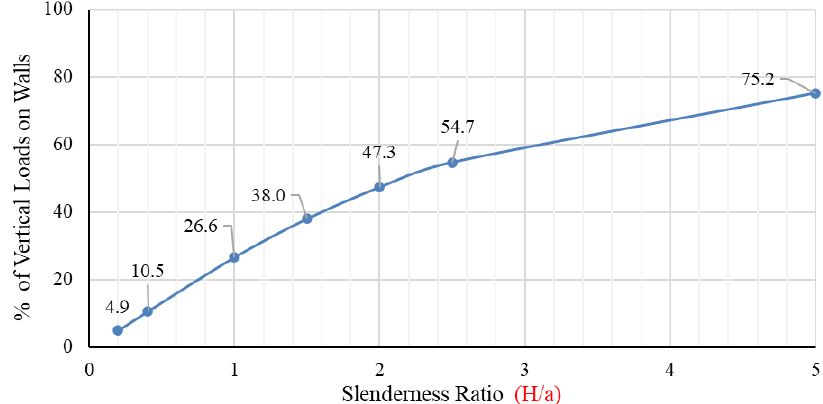
Figure 13. Percentage of vertical load distribution on flexible walls for different slenderness ratios.